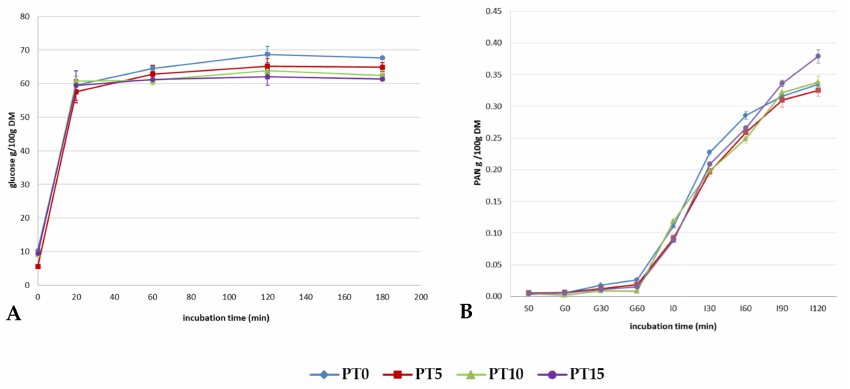
Figure 1. ( A ): graph of starch digestion of debittered trub powder (DTP) containing pasta vs. incuba- tion time. ( B ): graph of protein digestion of DTP pasta vs. incubation time. PT0: pasta formulated with 100% durum wheat semolina. PT5, PT10, PT15: 95:5, 90:10, 85:15 durum wheat semolina:DTP,